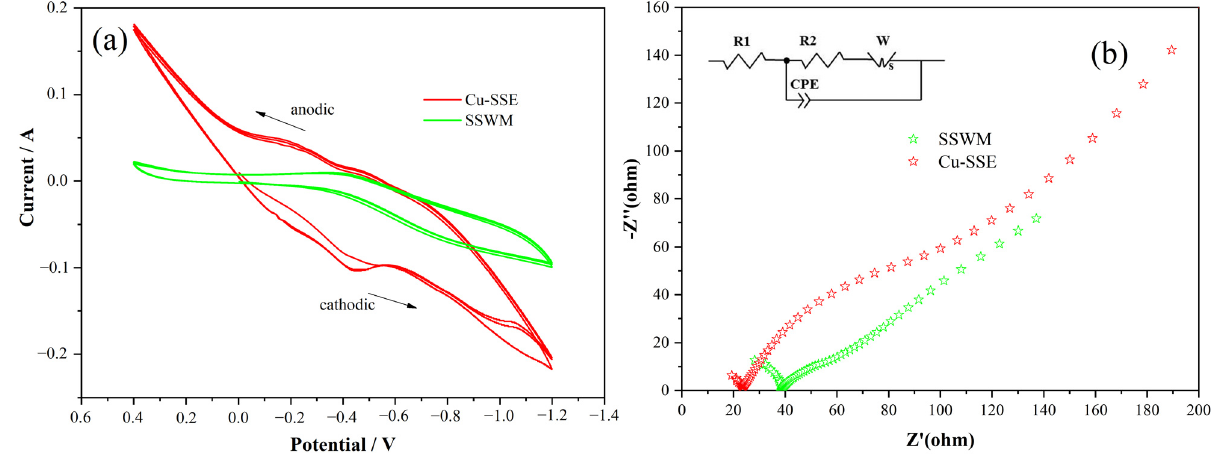
Figure 5. Electrochemical performance of SSWM and Cu-SSE: ( a ) CV test; ( b ) EIS test.